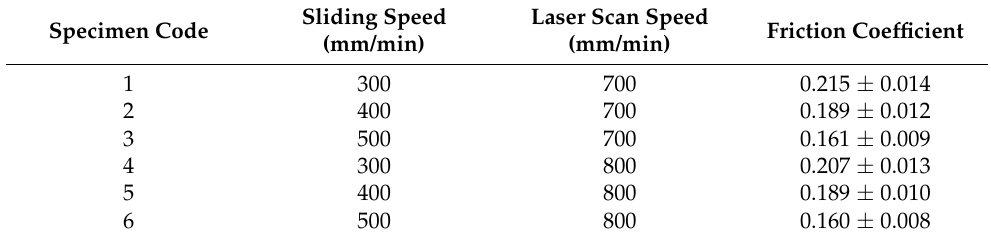
Table 5. Friction coefficient under lubricated conditions.